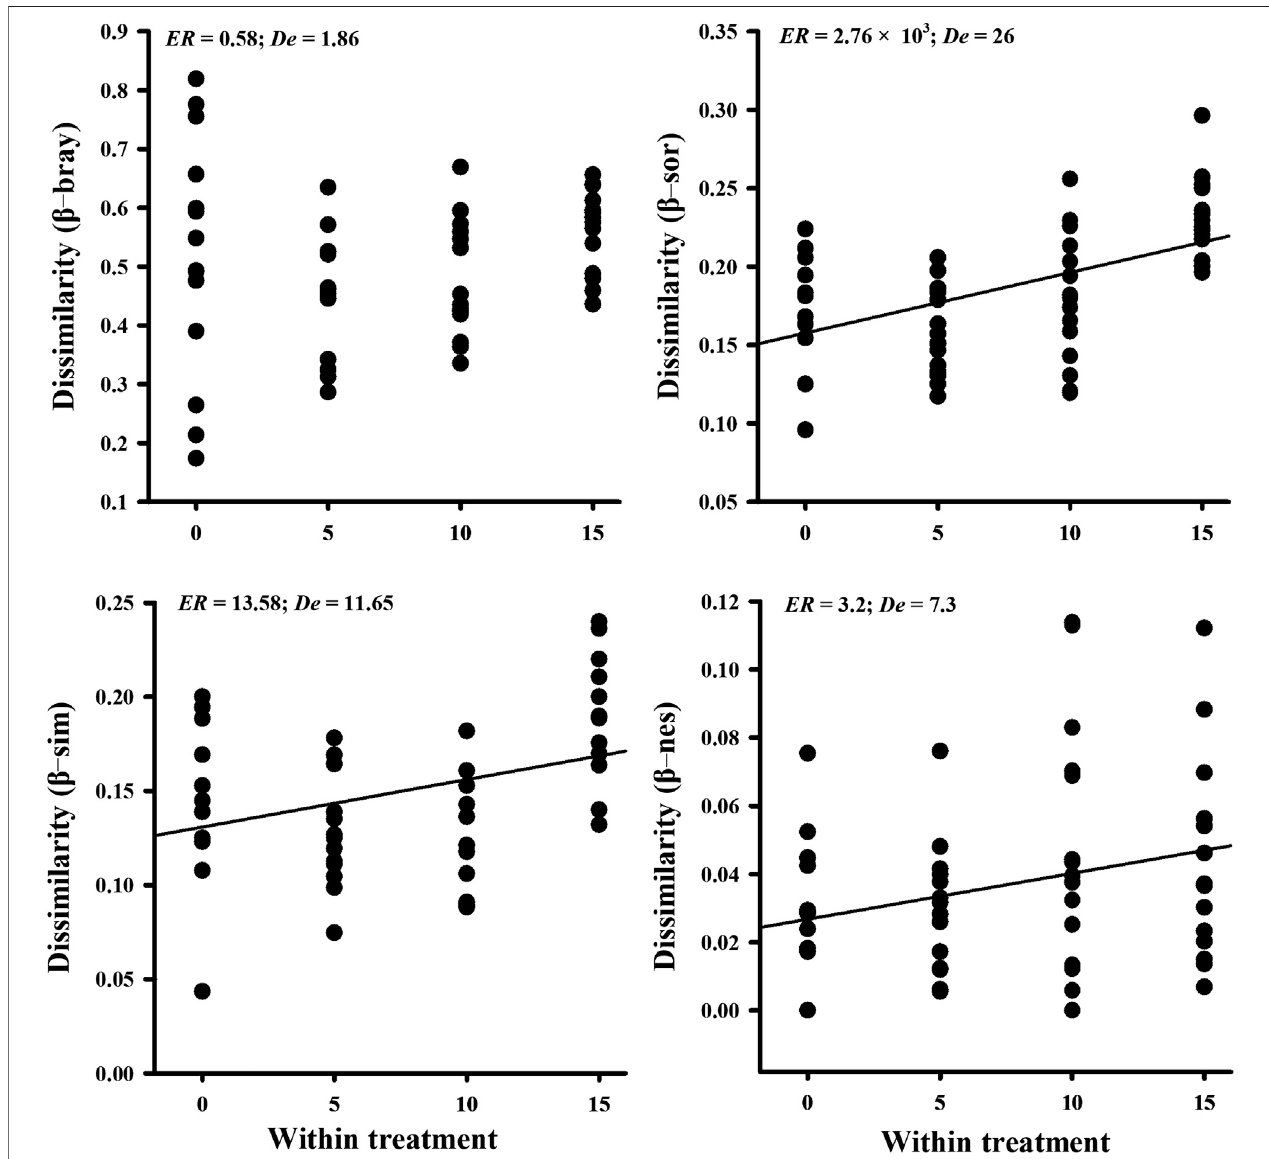
FIGURE 3 | Variation of the soil AMF community beta diversity of Bray – Curtis ( β -bray; abundance-weighted), Sørensen ( β -sor; presence/absence-based), partitioned Simpson ( β -sim), and nestedness ( β -nes) within four nitrogen addition treatments. ER > 1.5 means a signi fi cant relationship.